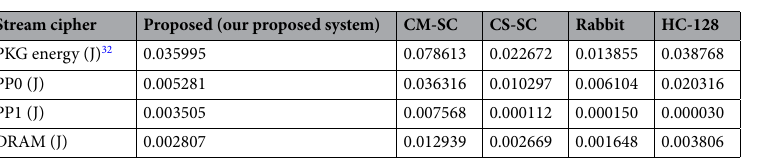
Table 1. RAPL power consumption